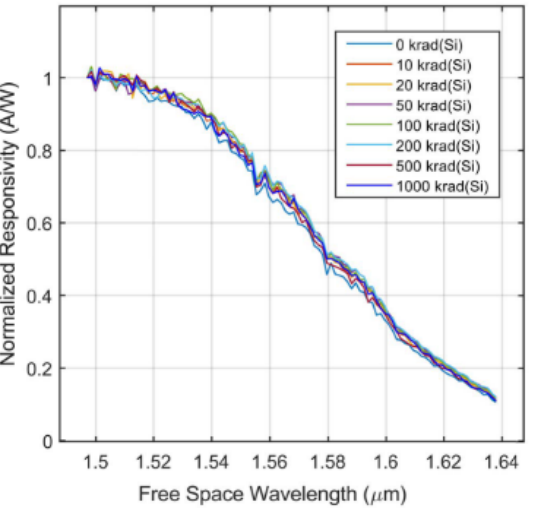
Figure 4. Photodiode responsivity for various TID levels (after